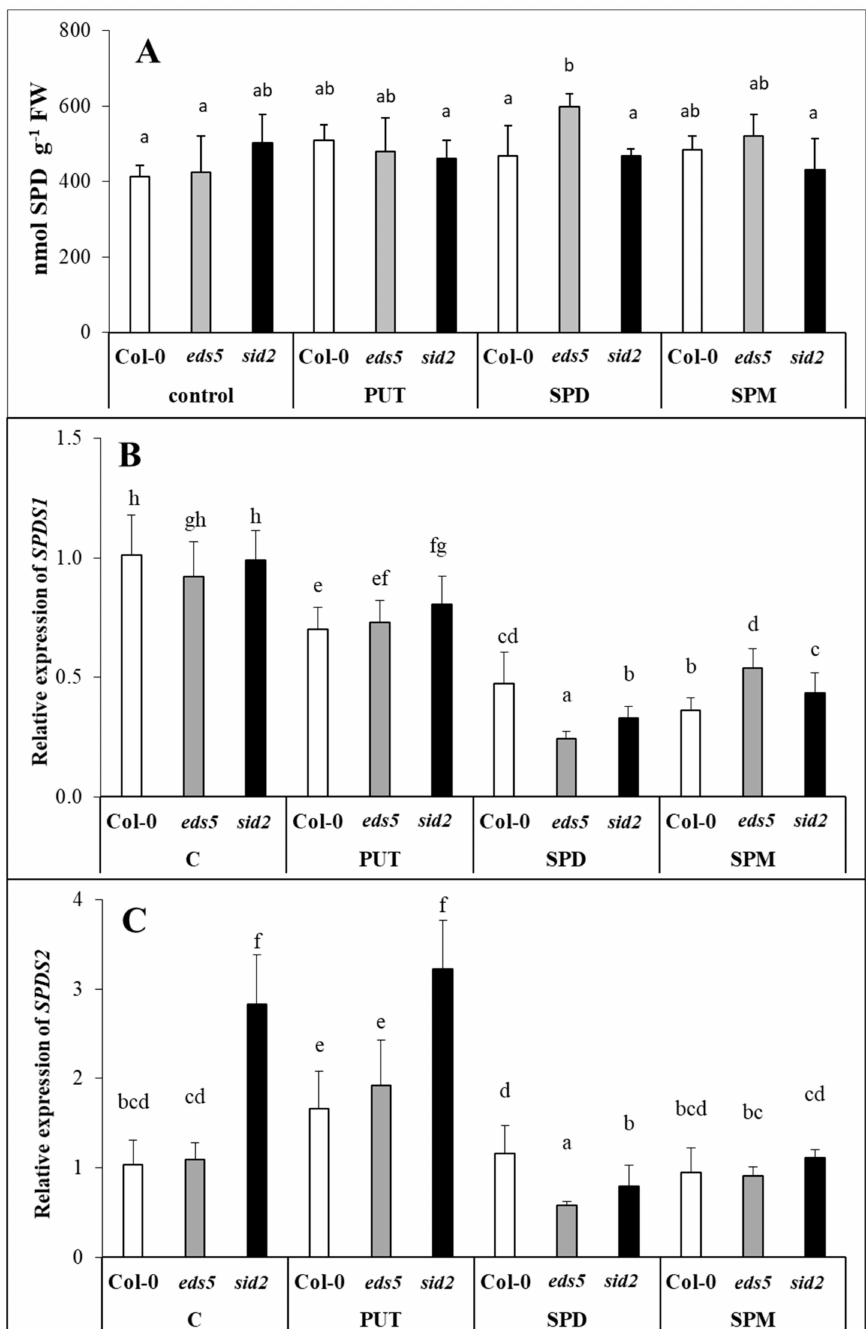
Figure 3. E ff ect of 0.5 mM 1-day of putrescine (PUT), spermidine (SPD) and spermine (SPM) treatments on spermidine content (( A ) SPD) and on the expression levels of spermidine synthesis genes ( B , C ) SPDS1-2 : spermidine synthase1-2) in Col-0, wild type, eds5-1 ( eds5 ) and sid2-2 ( sid2 ) Arabidopsis mutants. Data represent mean values ± SD. Di ff erent letters indicate significant di ff erences at p ≤ 0.05